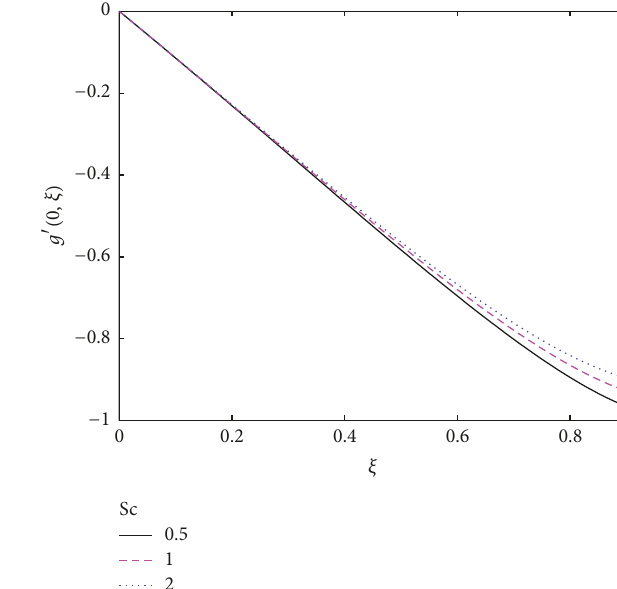
Figure 18: Effect of Sc on 𝑔 󸀠 (0,𝜉) ( 𝜎 = 𝛾 = 0.5, Pr = 3, 𝜆 = 1, ℏ = −0.5 ).